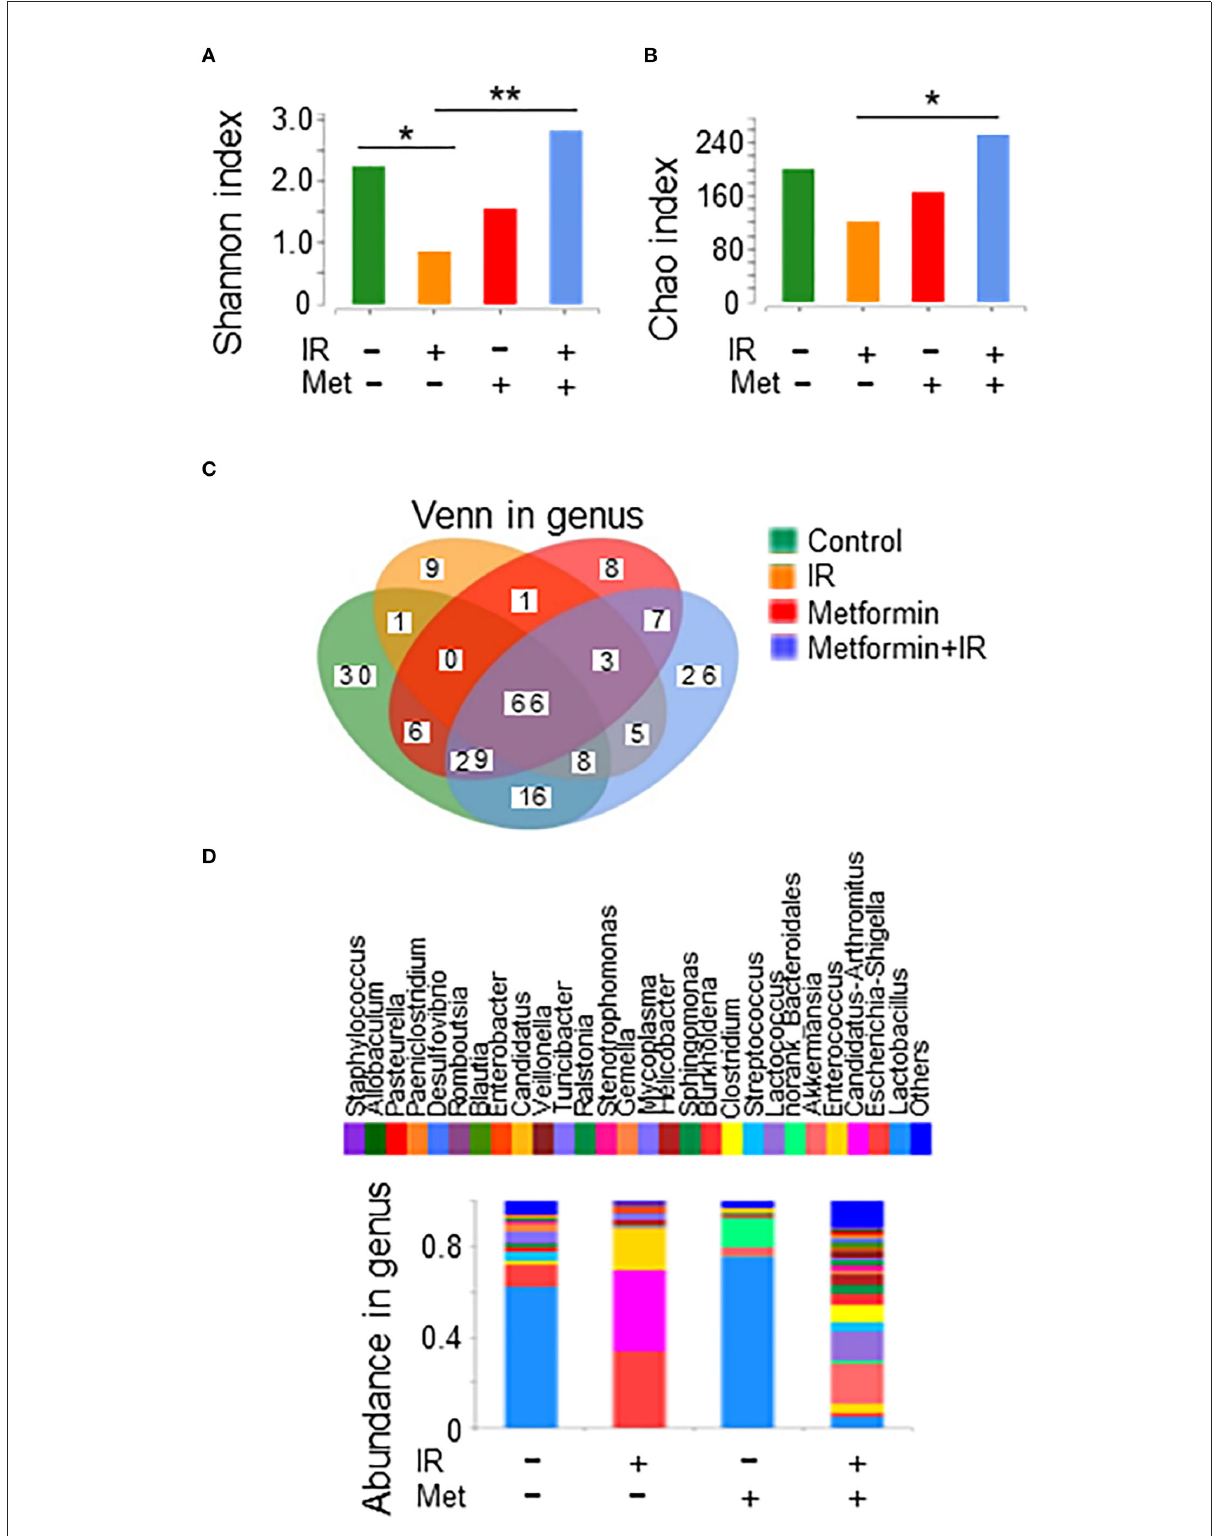
FIGURE2 Metformin improves the composition and abundance of intestinal flora in abdominal IR mice. Female BALB/c mice were treated with abdominal IR and/or metformin as described in Figure 1. Total DNAs were isolated from intestinal contents as described in the Materials and methods section and subjected to 16S rRNA sequencing. Intestinal flora is shown as follows: (A) diversity (Shannon index), (B) abundance (Chao index), (C) Venn in genus level, and (D) bacterial composition in the intestine of mice treated with or without metformin. Data represent mean ± SEM. * P < 0.05, ** P < 0.01, n = 3, metformin + IR vs. IR. Also, see Supplementary Figures S2,